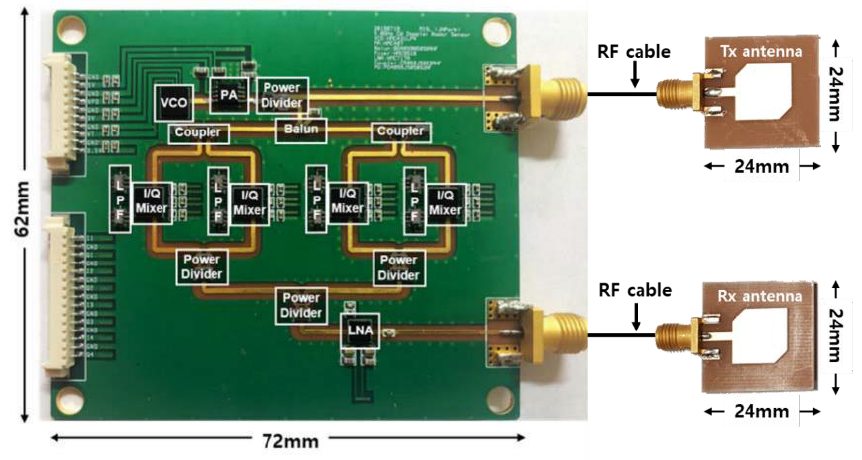
Figure 2. A 5.8 GHz continuous-wave Doppler radar sensors for the measurement of vital signs [43].